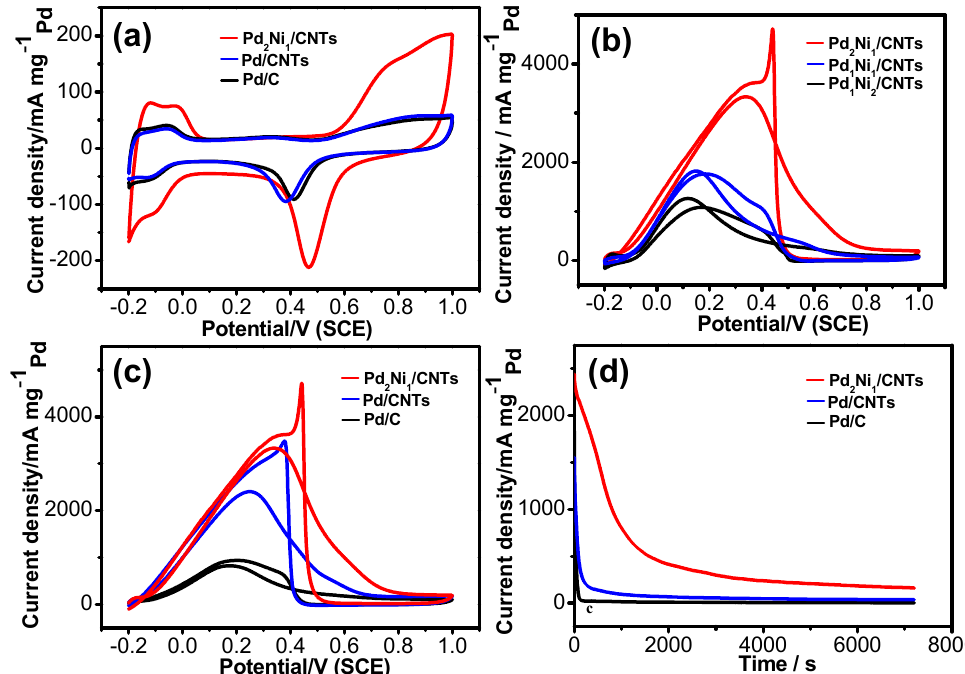
Figure 4. ( a , c ) Cyclic voltammograms and ( d ) current–time curves of Pd 2 Ni 1 /CNTs, Pd/CNTs, and Pd/C; ( b ) cyclic voltammograms curves of Pd 2 Ni 1 /CNTs, Pd 1 Ni 1 /CNTs, and Pd 1 Ni 2 /CNTs in 0.5 M H 2 SO 4 /1.0 M HCOOH + 0.5 M H 2 SO 4